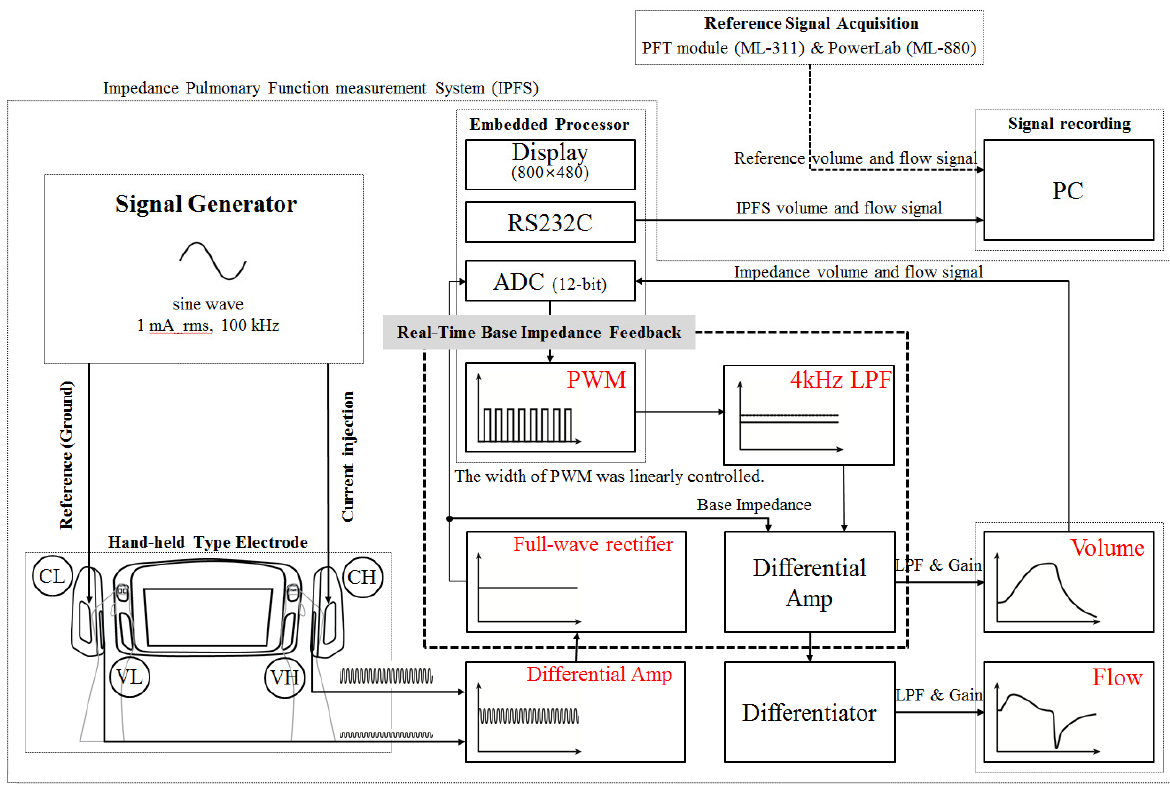
Figure 1. Block diagram of IPFS, CH was used to inject the current and VH and VL were used to measure the voltage generated. CL was used as a reference electrode. Hand-held typed electrodes: electrodes VL and VH (dimensions: 15 × 55 × 2 mm each) and electrodes CL and CH (dimensions: 23 × 55 × 2 mm each). PWM output signals were linearly controlled in accordance with acquired the base